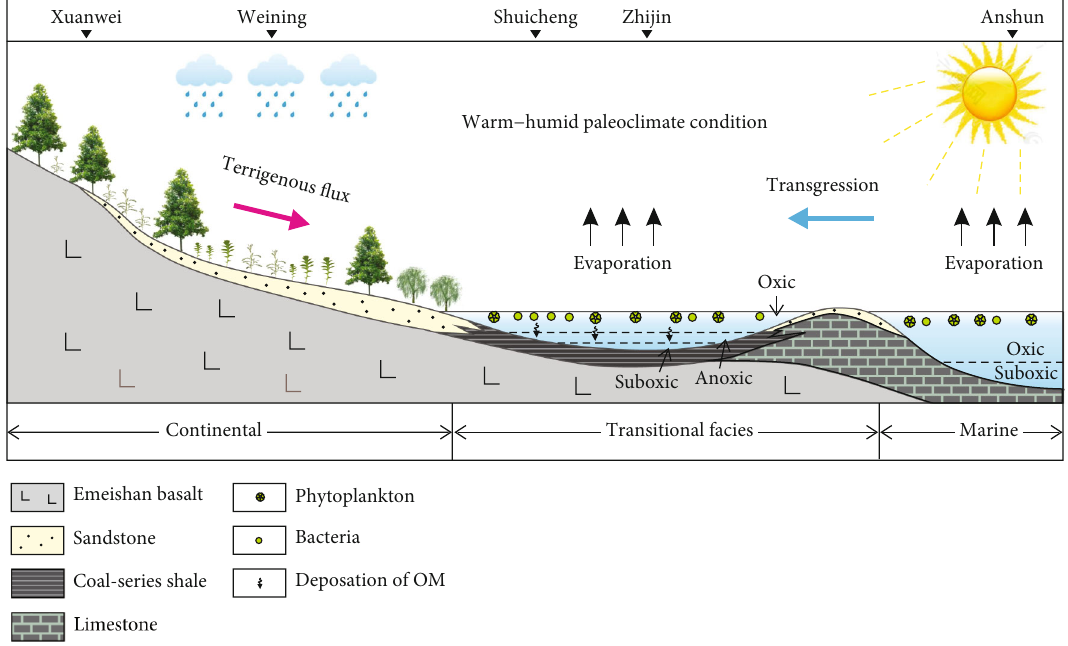
Figure 8: (a) Ternary diagram of regular steranes (C Longtan coal series shale.